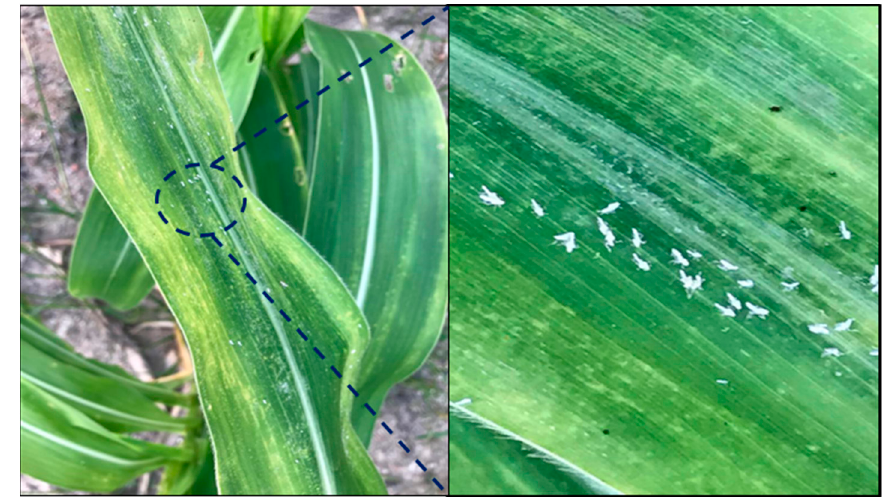
Figure 1. Mosaic symptoms on the lower leaves and yellow streaks along veins in corn plant as it approaches maturity. Also the fitch, Rhopalosiphum maidis , nymphs on the maize leaves.